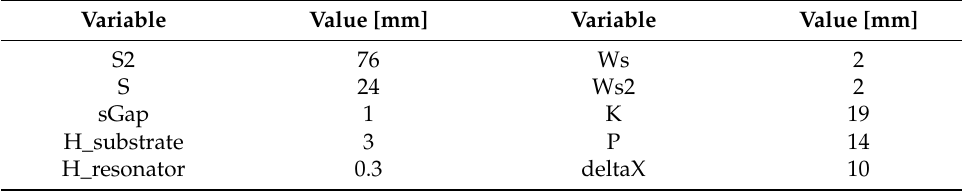
Figure 6. Finished Ecoflex tag with conductive ink. Table 3. Latex EDM tag dimensions.